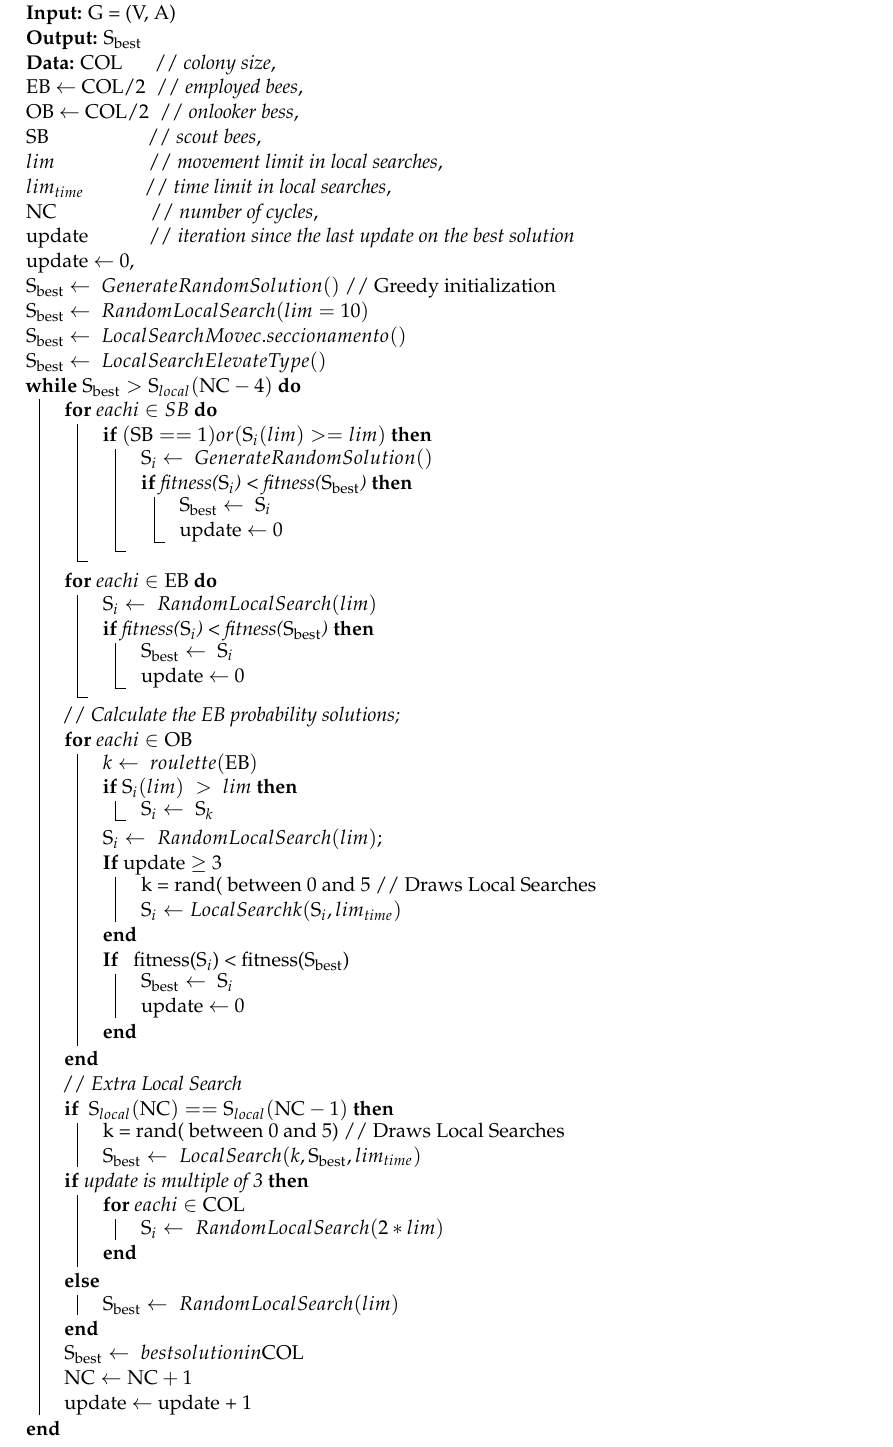
Algorithm 1: GABC